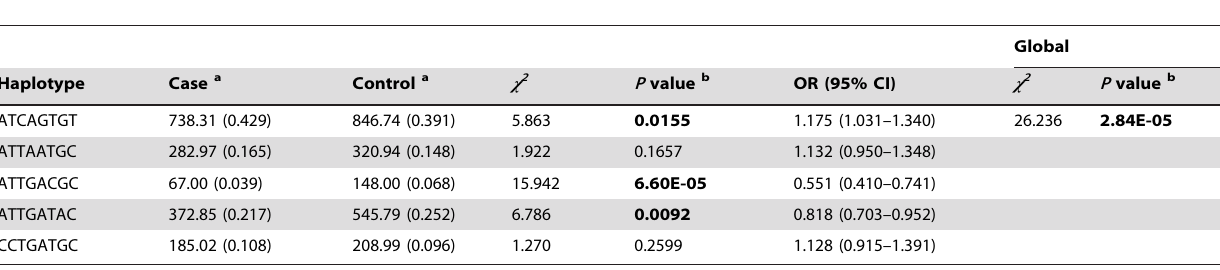
Table 2. Haplotype results of the entire block for the case–control association